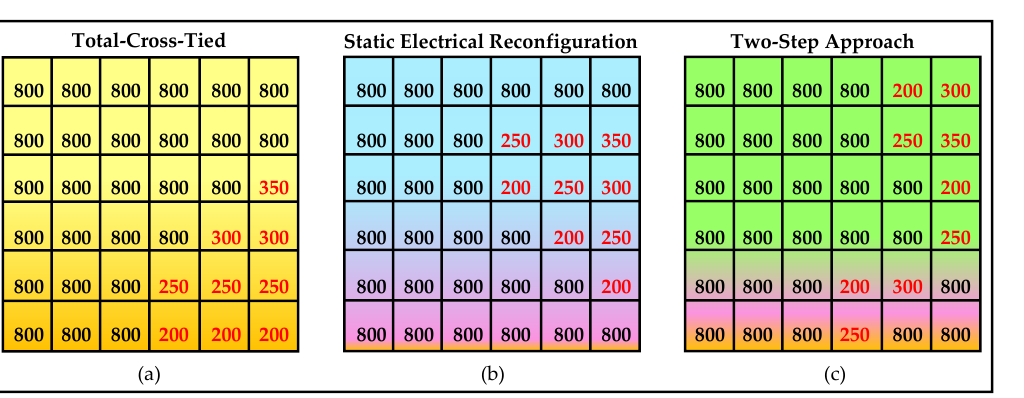
Figure 8. Graphical comparison of two-step approach under partial shading S1. ( a ) P~V curve comparison with conventional configurations, ( b ) P~V curve comparison with hybrid configurations, ( c ) P~V curve comparison with the static reconfiguration technique, and ( d ) comparison of the parameters among all configurations.